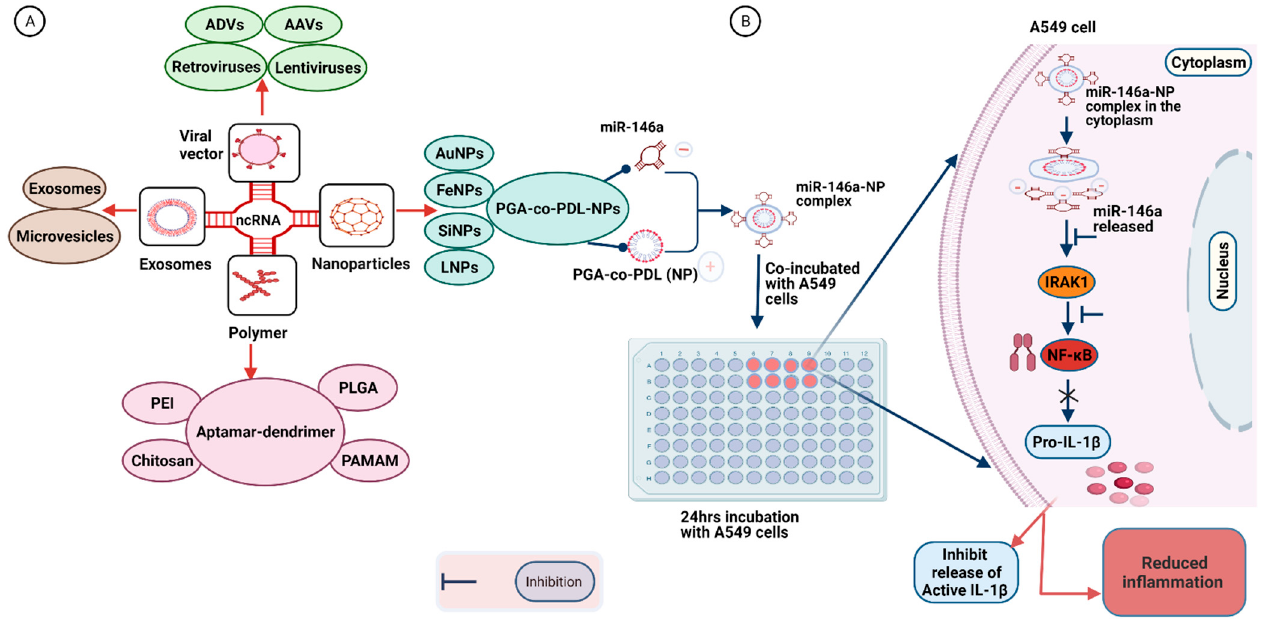
Figure 3. Vectors currently in use for the delivery of therapeutic ncRNAs. ( A ) Shows the different vectors and their subcategories, include viral vectors, polymers and their derivatives, nanoparticles and their derivatives, and exosomes-based delivery systems. ( B ) Shows the delivery of miR-146a in to A549 cells. Negatively charged miR-146a is adsorbed with a positively charged PGA-co-PDL (NPs) when co-incubated with A549 cells. After 24 h of incubation, the miR-146a-NPs complex enters into the A549 cells and is released into the cytoplasm. The released miR-146a then inhibits the